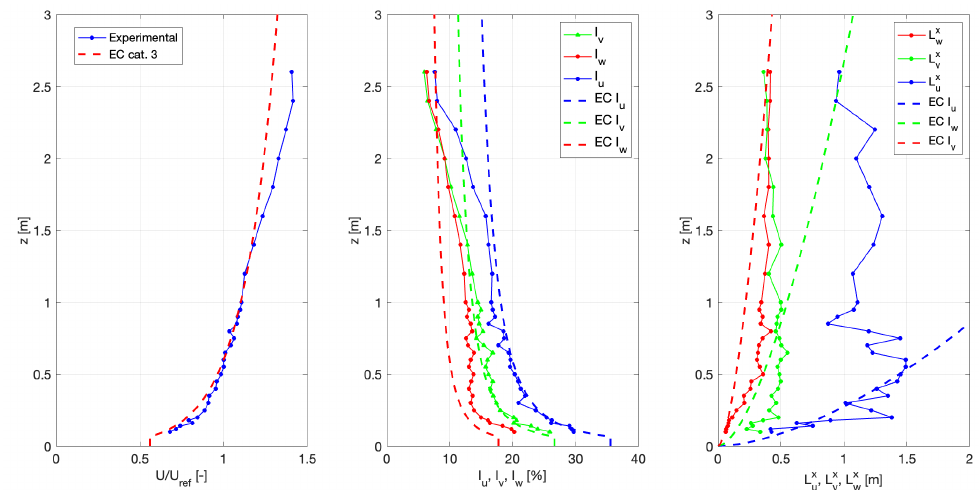
Figure 6. Wind profiles used for the wind tunnel tests. Left : mean speed profile. Centre : Turbulence intensities. Right : Integral length scales.